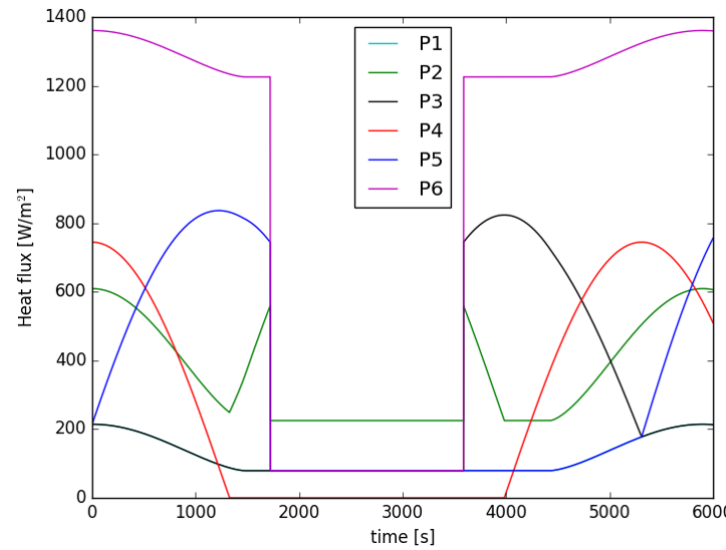
Figure 2. Radiative heat fluxes over each CubeSat panel as function of time along one orbit ( β = 57 ◦